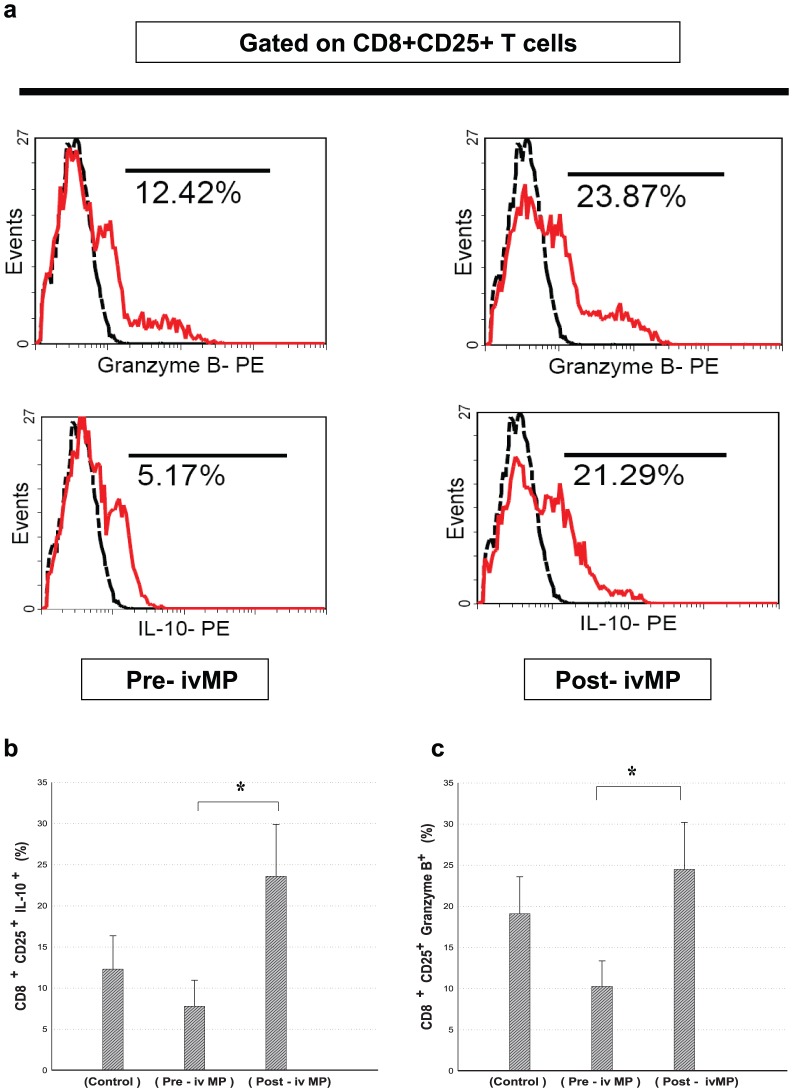
Intracellular IL-10 and granzyme B levels in CD8+CD25+ Treg cells before and after IVMP.PBMCs were stimulated with anti-CD3 mAb for five days, followed by stimulation of PMA (10 ng/ml) plus ionomycin (1 µg/ml) for the last five hours, with addition of brefeldin A (10 µg/ml) for the final hour. Intracellular expression of IL-10 and granzyme B was measured by gating in CD8+CD25+ T cells, using flow cytometry. Isotype control (dotted line). (a) Results of 30 paired experiments for IL-10 (b) and granzyme B (c) production by PBMCs (* p<0.05).